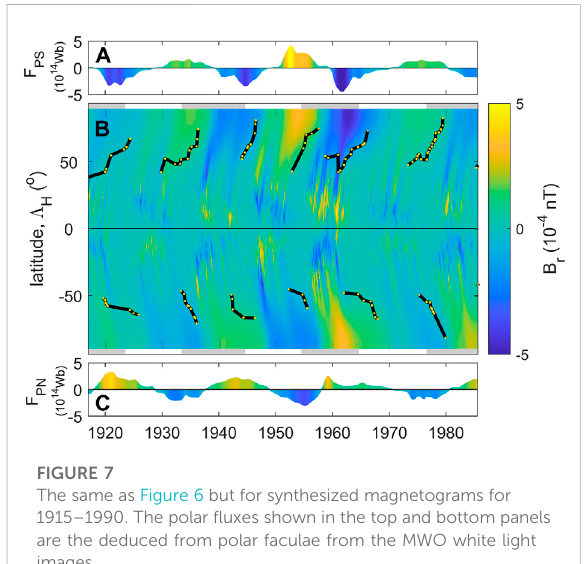
FIGURE 7 The same as Figure 6 but for synthesized magnetograms for 1915 – 1990. The polar fl uxes shown in the top and bottom panels are the deduced from polar faculae from the MWO white light